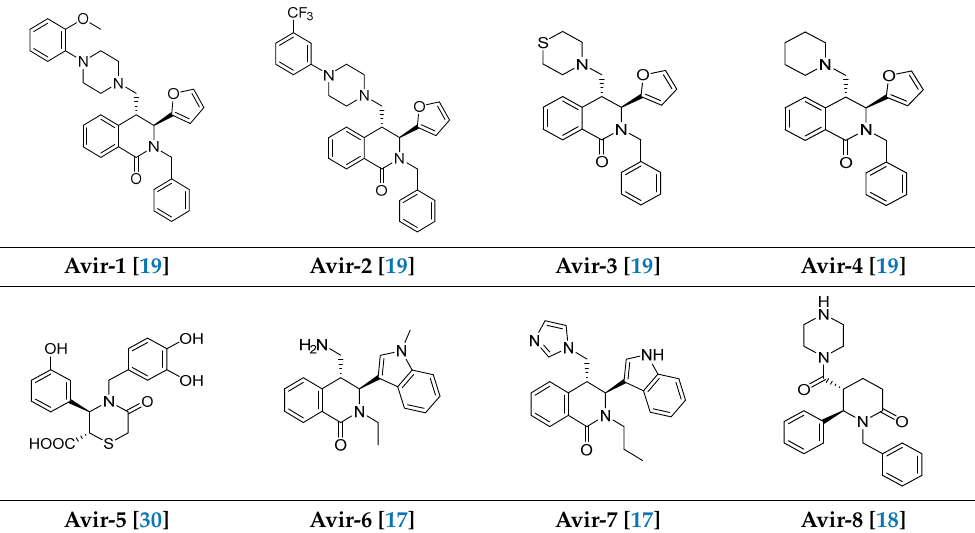
Table 2. Structures of the compounds Avir 1 – 8 .